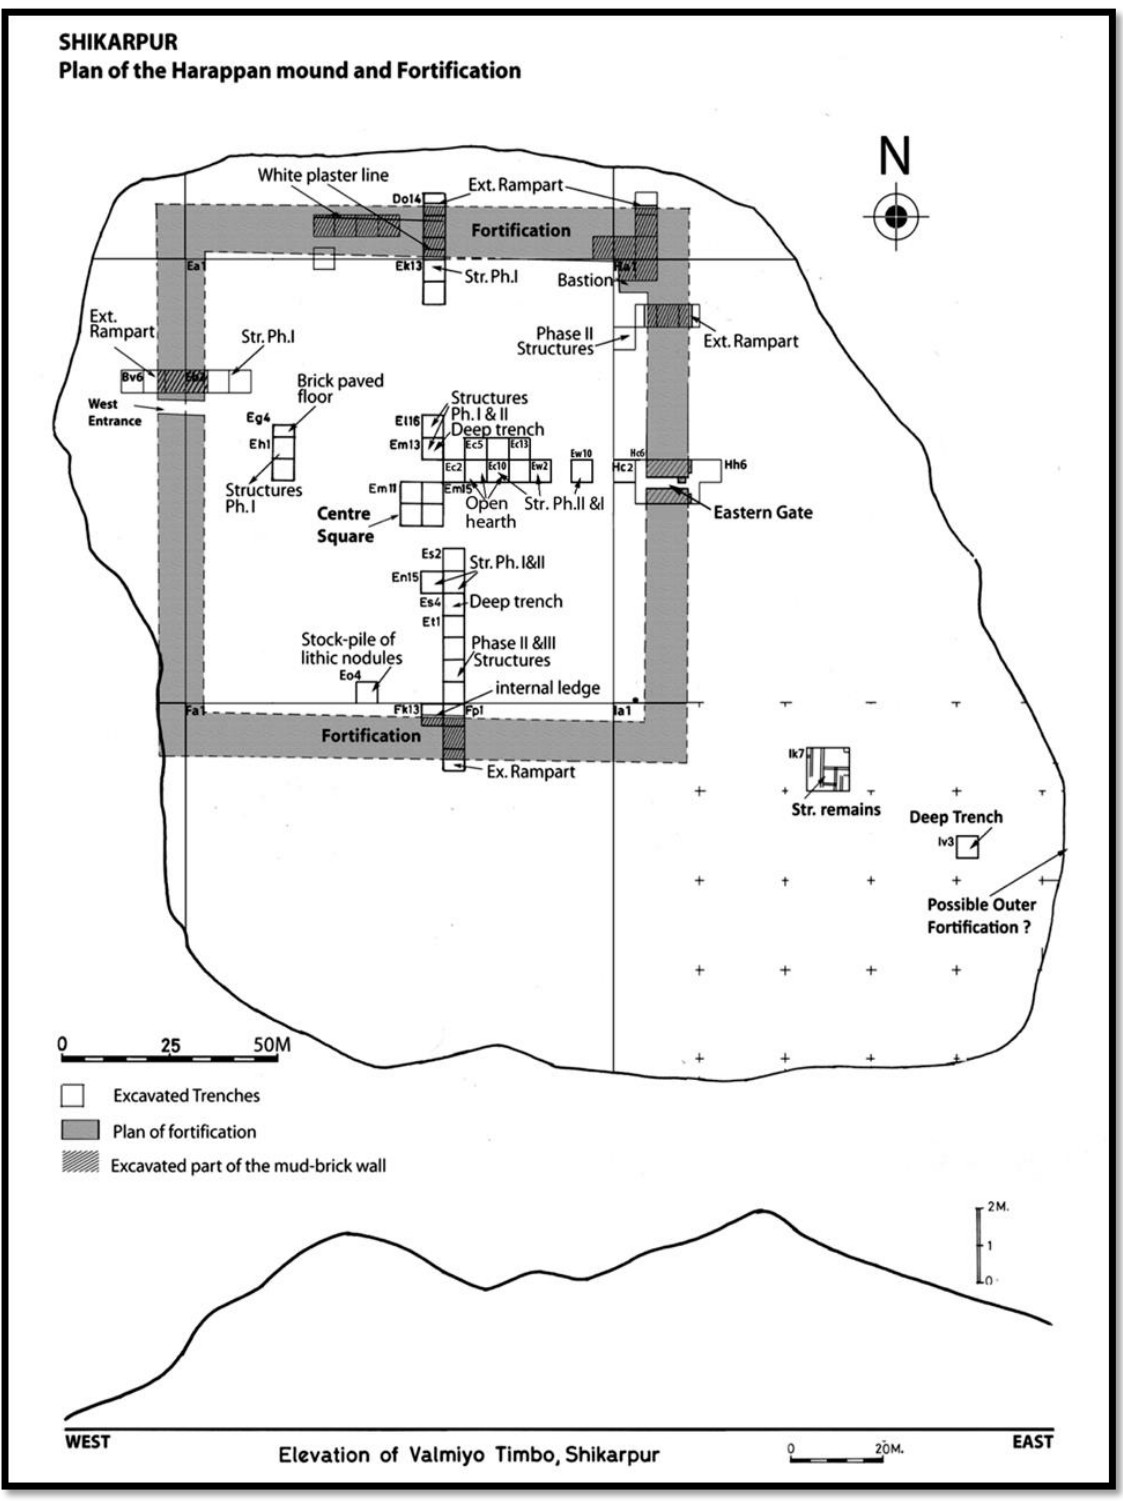
Figure 2. Plan of the Harappan site at Shikarpur showing features of the fortification wall with eastern entrance gate and plan of structures, both inside and outside of the fortified area. (Courtesy: Department of Archaeology and Ancient History, The M.S.U. of Baroda,